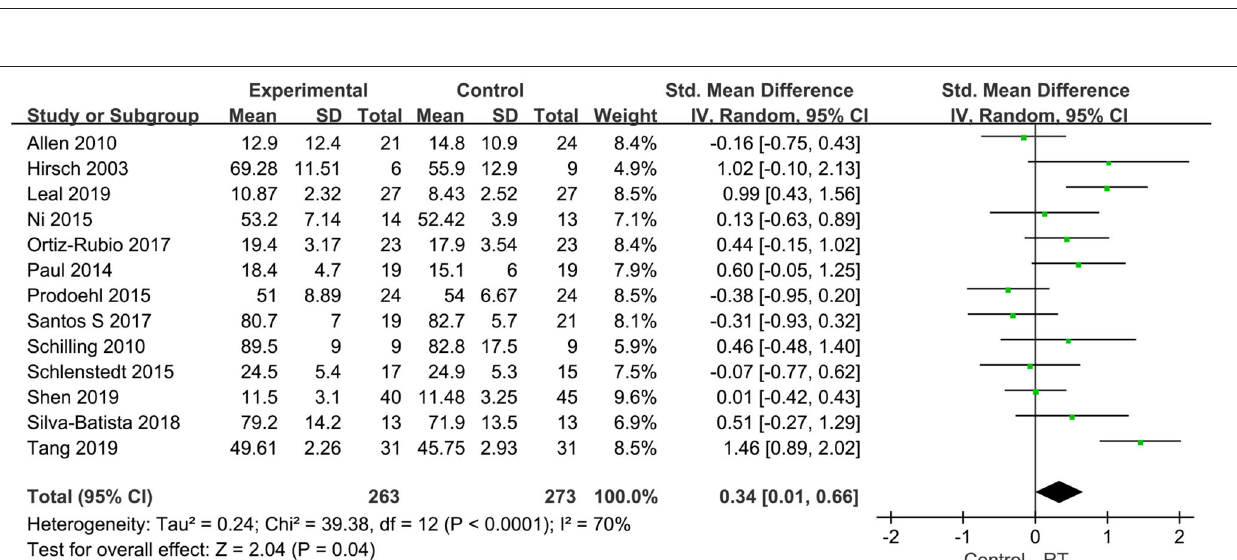
FIGURE 3 | Forest plots of the effects of lower limb RT on leg strength in PD. CI, confidence interval.